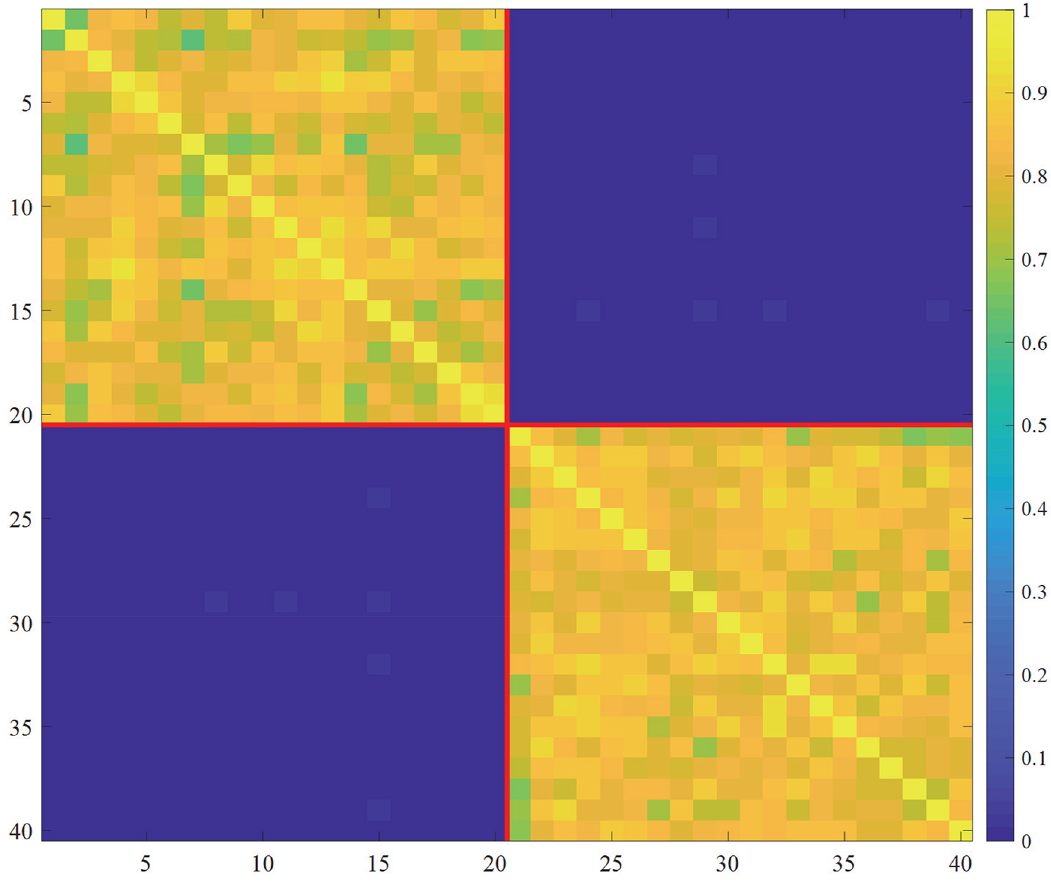
Fig 3. A correlation matrix which reflects two subsets of variables {1, 2, ... , 20} and {21, 22, ... , 40}.